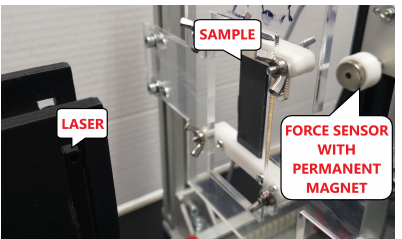
Figure 7. The laboratory set up for analysing the force of MRE beam.